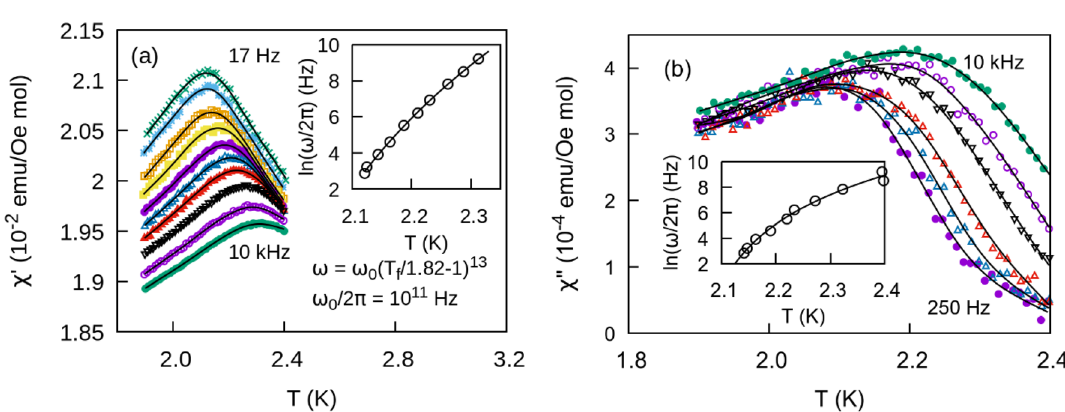
Figure 10. (a) χ ′ and (b) χ ′′ versus temperature. Insets are fits to Eq. (5). H ac varies as shown in Fig.